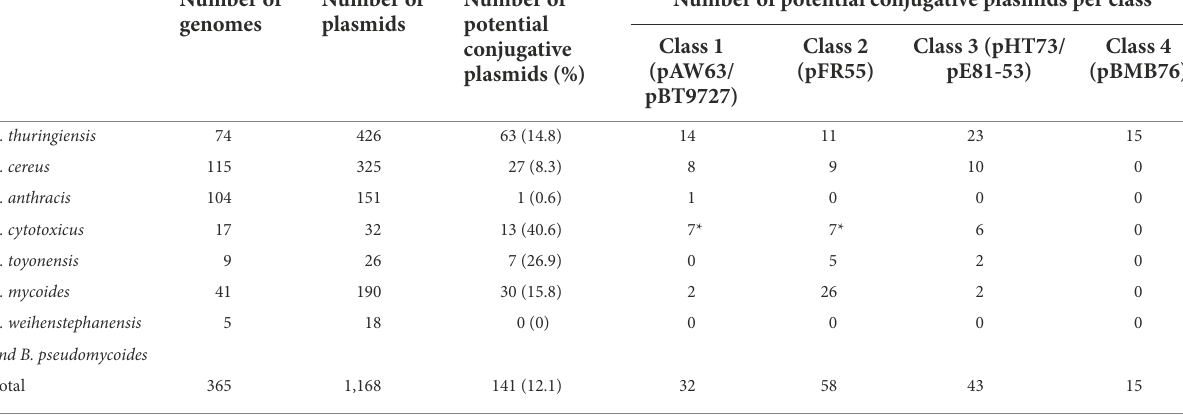
TABLE 3 Identification of potential conjugative plasmids within the B. cereus group. Plasmids retrieved from closed genomes of B. thuringiensis , B. cereus , B. anthracis , B. cytotoxicus , B. toyonensis , B. mycoides and B. weihenstephanensis - B. pseudomycoides were analyzed for their protein sequence similarities with the model conjugative plasmids of four distinct classes. The potential conjugative plasmids encode at least two ATPase- like and one peptidoglycan hydrolase-like proteins sharing ≥ 60% sequence coverage and ≥ 35% sequence identity with the respective conjugative elements of a model conjugative